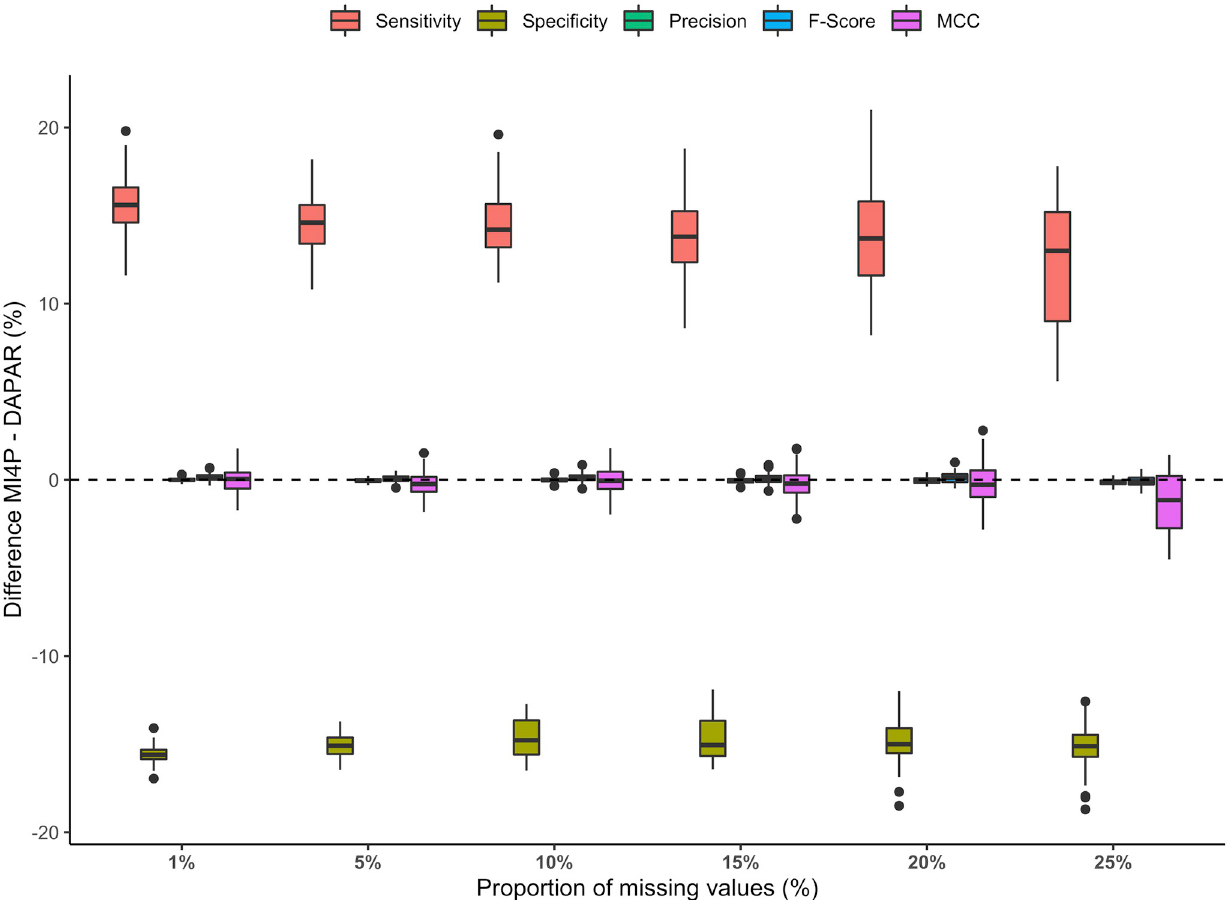
Fig 11. Distributions of differences in sensitivity, specificity, precision, F -score and Matthews correlation coefficient for the second MCAR + MNAR set of simulations. Missing values were imputed using the maximum likelihood estimation method.